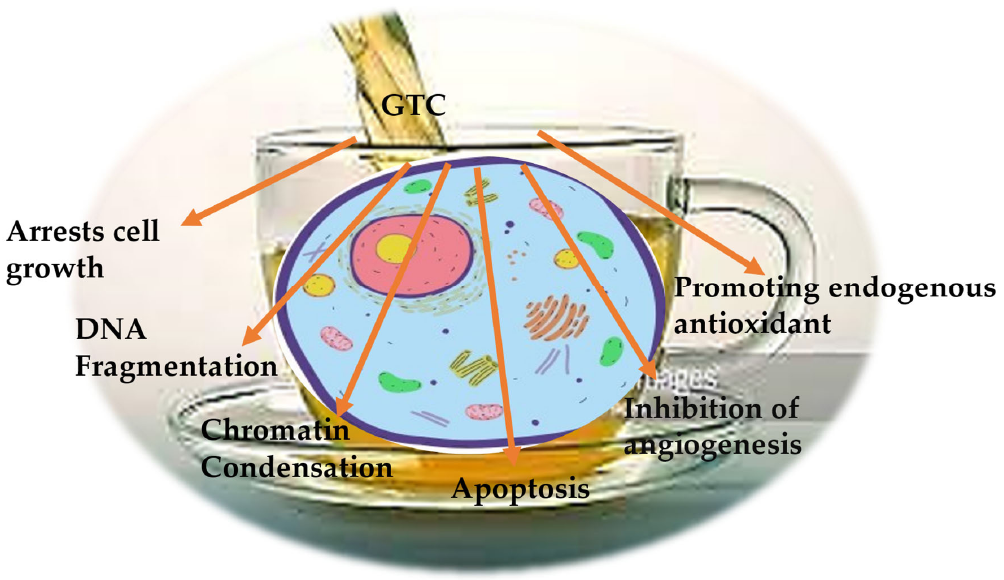
Figure 2. The anticancer mechanisms of GTCs.